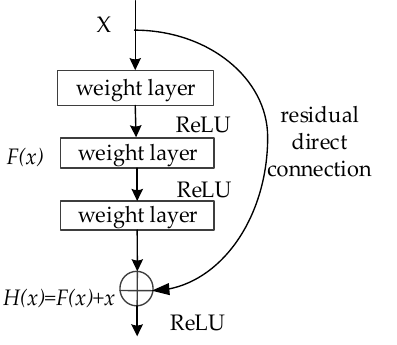
Figure 5. Structure chart of three-layer bottleneck layer residual unit.